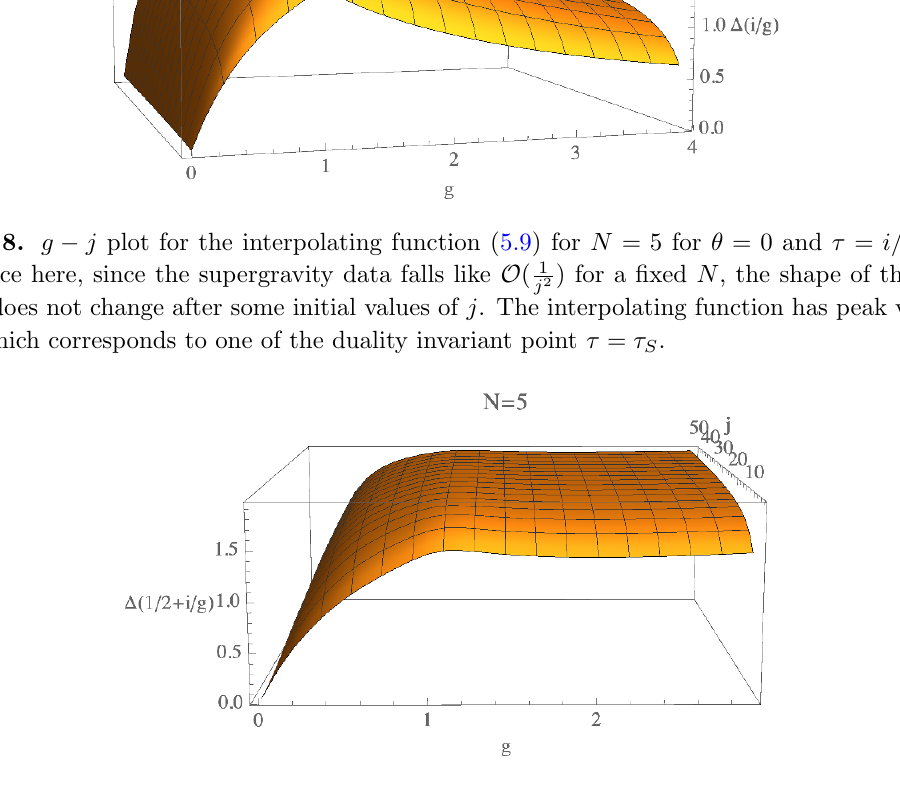
which corresponds to one of the duality invariant 3